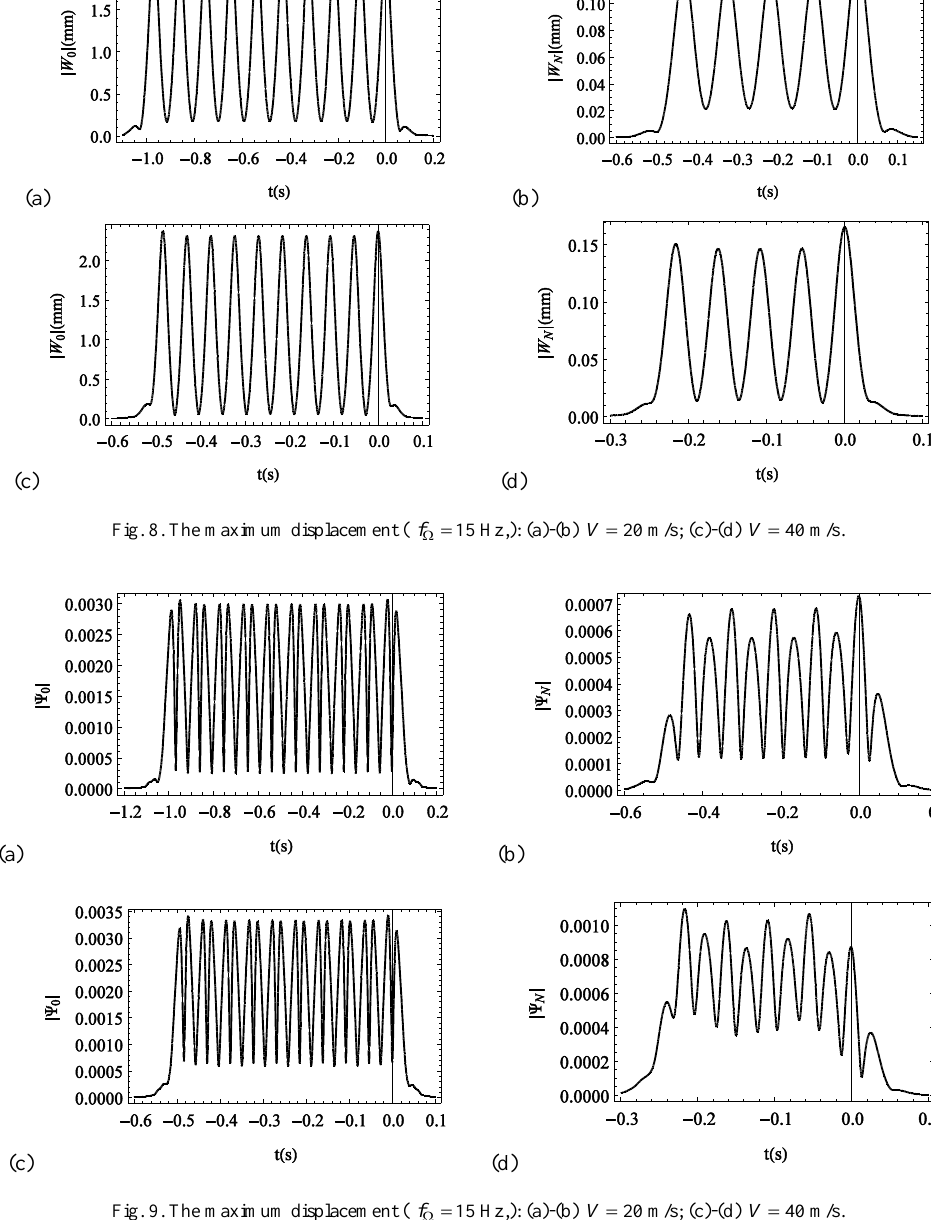
Fig. 9. The maximum displacement